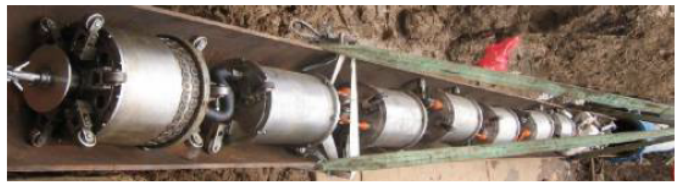
Figure 39. A worm-type in-pipe robots with multiple segments. Reprinted from Industrial Robot, Volume 37, Issue 2, Wang, Z.; Cao, Q.; Luan, N.; Zhang, L.; Meniconi S. Development of An Autonomous In-pipe Robot for Offshore Pipeline Maintenance, Year 2014 with permission from Emerald Publishing Limited